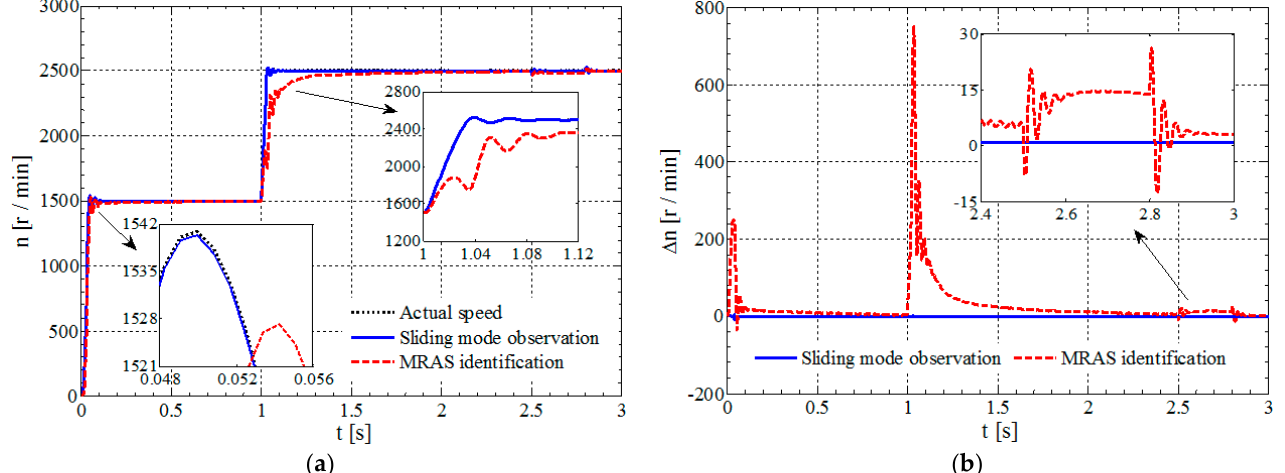
Figure 5. Speed response waveform with load: ( a ) Observed motor speed; ( b ) Observation error of motor speed. Under the conditions of loading and speed regulation, the observation response waveform and observation error waveform of motor speed are given in Figure 5.